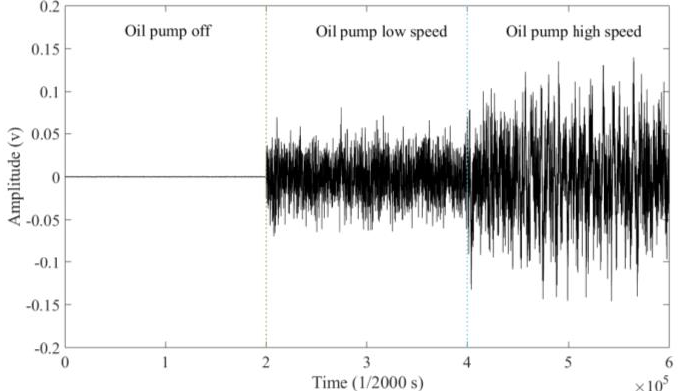
Figure 13. Background signals in different statuses of the lubricating oil pump.